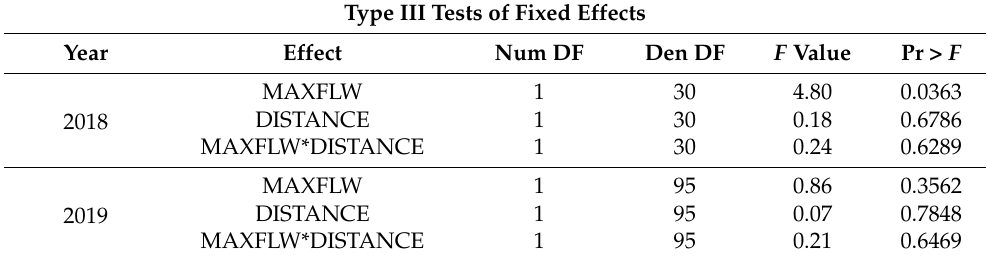
Table A22. The effect of interplant distance and flower number on filled seed proportion at Shinob Kibe in 2018 and